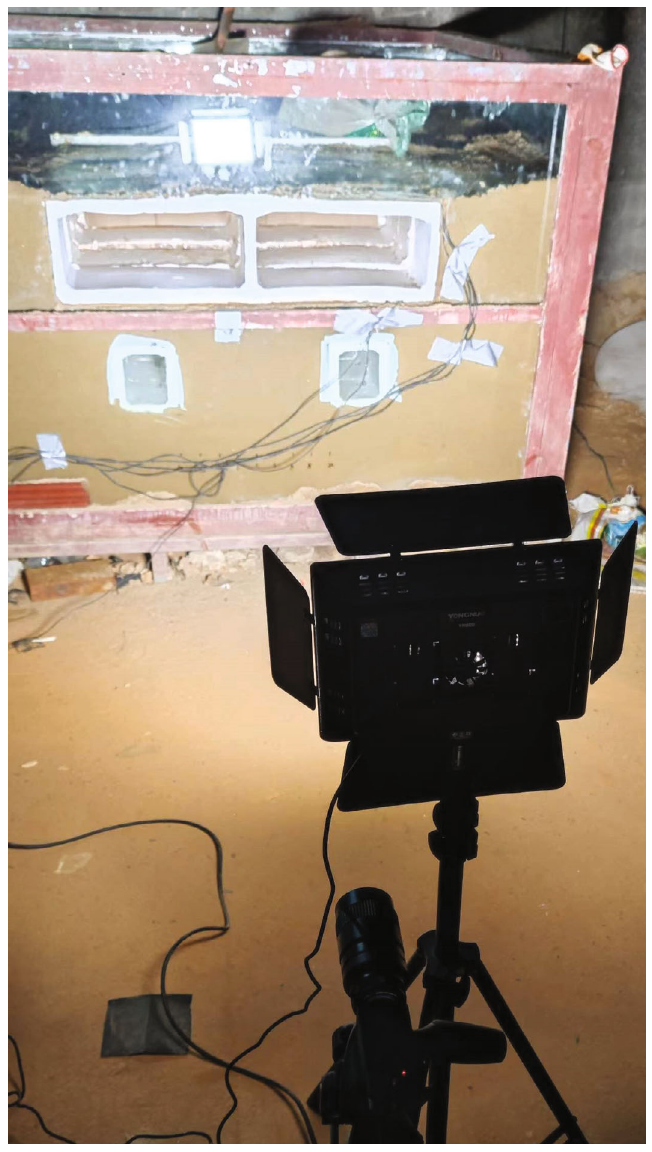
Figure 6: VIC two-dimensional noncontact full- fi eld strain measurement system.